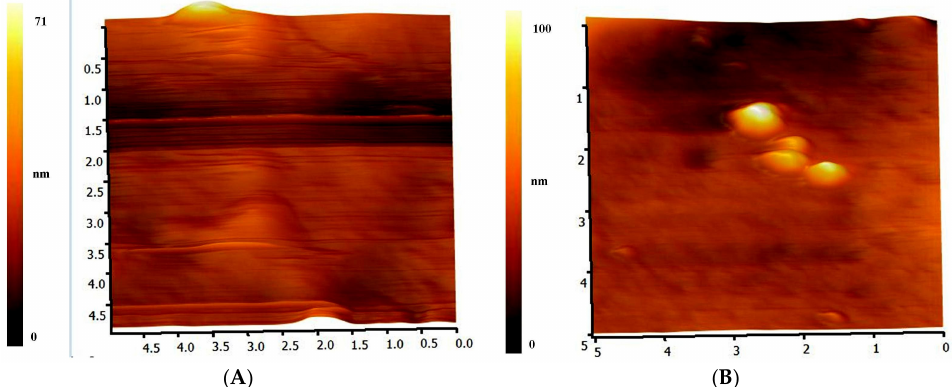
Figure 8. Representative AFM images of pristine and Aloe vera dip-coated mPE-nHA. ( A ) Pristine mPE-nHA; ( B ) 24 h Aloe vera dip-coated mPE ‐ nHA.